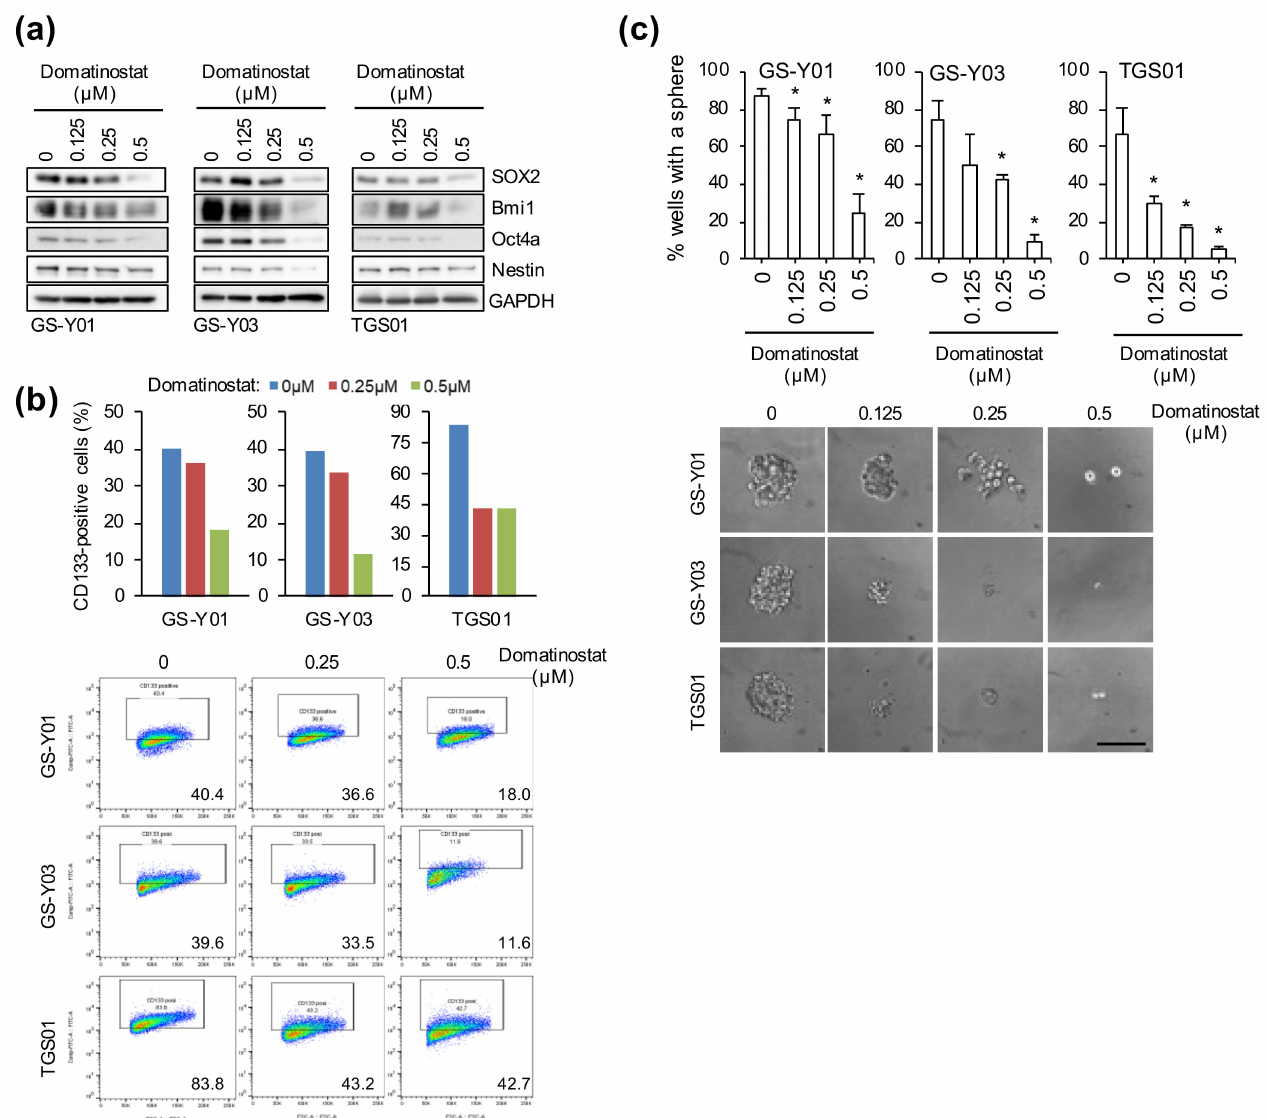
Figure 4. Effect of domatinostat on the self-renewal capacity of glioma stem cells. ( a , b ) Stem cell marker expression. Cells treated with the indicated concentrations of domatinostat for 3 days were subjected to Western blot analysis of the expression of the indicated proteins ( a ), or to flow cytometric analysis of CD133 expression on the cell surface to determine the percentage of CD133-positive cells ( b ). Representative flow cytometric plots together with the percentage of CD133-positive cells are also shown in ( b ). ( c ) Sphere formation assay. GS-Y01, GS-Y03, and TGS01 cells treated with domatinostat at the indicated concentrations for 3 days were subjected to the sphere formation assay in the absence of domatinostat. Top: percentage of wells in which a tumorsphere was formed from a single cell. * p < 0.05 vs. cells treated without domatinostat (i.e., at 0 µ M) by the Student’s t- test. Bottom: photomicrographs of representative wells. Bar: 100 µ